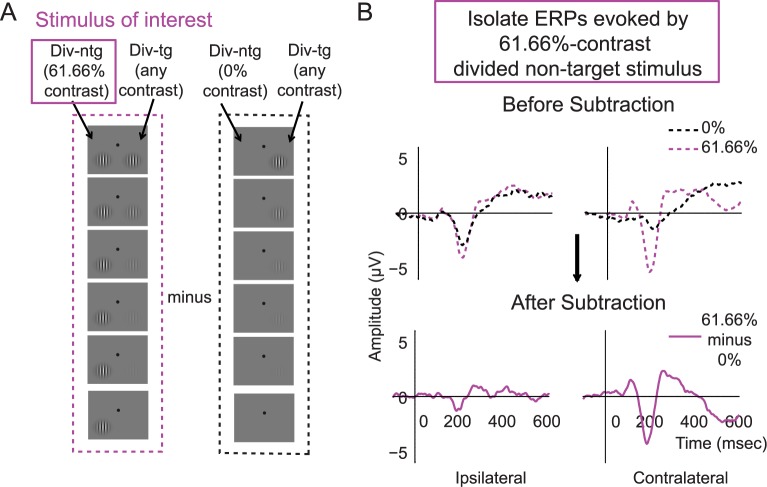
An example of the event-related potential (ERP) subtraction method.(A) Left column (in purple): schematic of a 61.66% contrast divided nontarget stimulus presented in the left hemifield (termed the stimulus of interest) and paired with target stimuli rendered in all different contrasts (down the rows). Right column (in black): the divided nontarget 0% contrast stimulus in the left hemifield paired with the same set of target stimuli in the right hemifield. (B) In this case, the ERP response evoked by the left divided nontarget stimulus of 0% contrast (A, right; B, top, black dotted traces) was subtracted from the ERP response evoked by the left divided nontarget stimulus of 61.66% contrast (A, left; B, top, dotted purple traces), resulting in the baseline-subtracted ERP response (B, bottom, solid purple traces). A similar subtraction was done to compute the ERPs associated with stimuli of interest rendered at all other contrasts. Note that the stimulus paired with the stimulus of interest (in this case, the right divided target stimulus) was equally likely to have any of the 6 contrast values. Therefore, this method amounts to subtracting out the mean response to all ipsilateral stimuli.